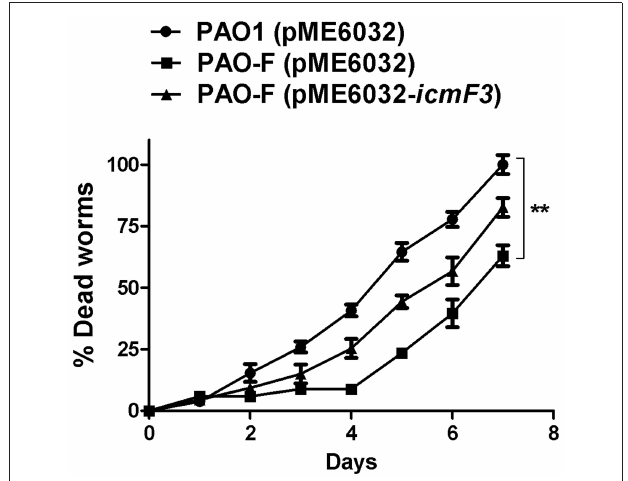
FIGURE 11 | IcmF3 is required for virulence in C. elegans . C. elegans was infected with PAO1 and the icmF3 mutant. 1mM IPTG was included in the medium for induction. The kinetics of the killing of C. elegans by P. aeruginosa is shown for each strain. ** P < 0.01 .